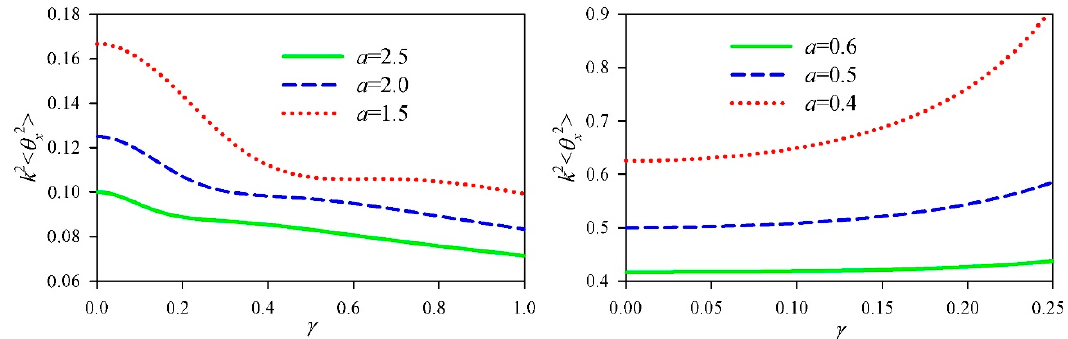
Figure 5. By giving the cosh parameter γ , the square of the beam waist in the x -direction of the cosh-Airy beam as a function of the decay factor a is shown.